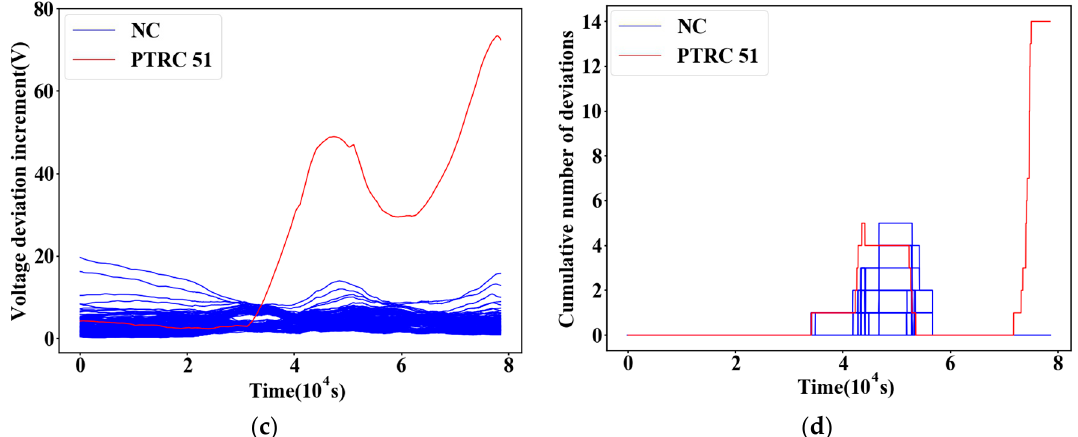
Figure 9. ( a ) The VDI curves of vehicle 1; ( b ) The CND curves of vehicle 1; ( c ) The VDI curves of vehicle 2; ( d ) The CND curves of vehicle 2.